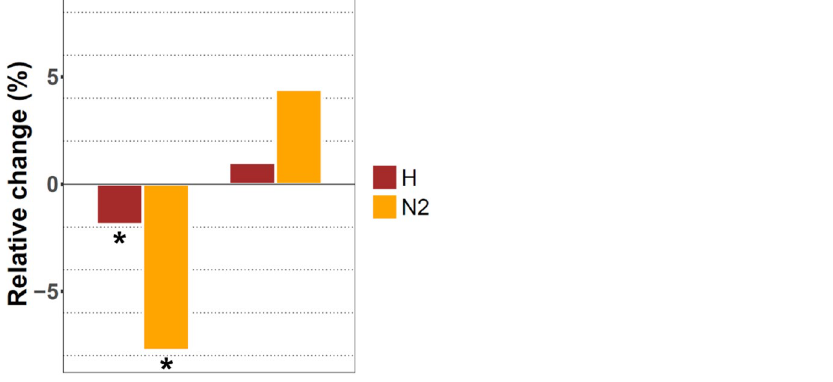
Figure 3. Changes in alpha diversity of intestinal microbiota in individuals post-cholecystectomy (PCE) and gallstone carriers (GC). Bars depict the relative change (%) of the mean for Shannon diversity index (H, brown), and Simpson diversity number (N2, orange) of PCE (n = 580) and GC cases (n = 404) compared to their respective control group (n = 580 and n = 404, respectively). *Indicates a significant result.